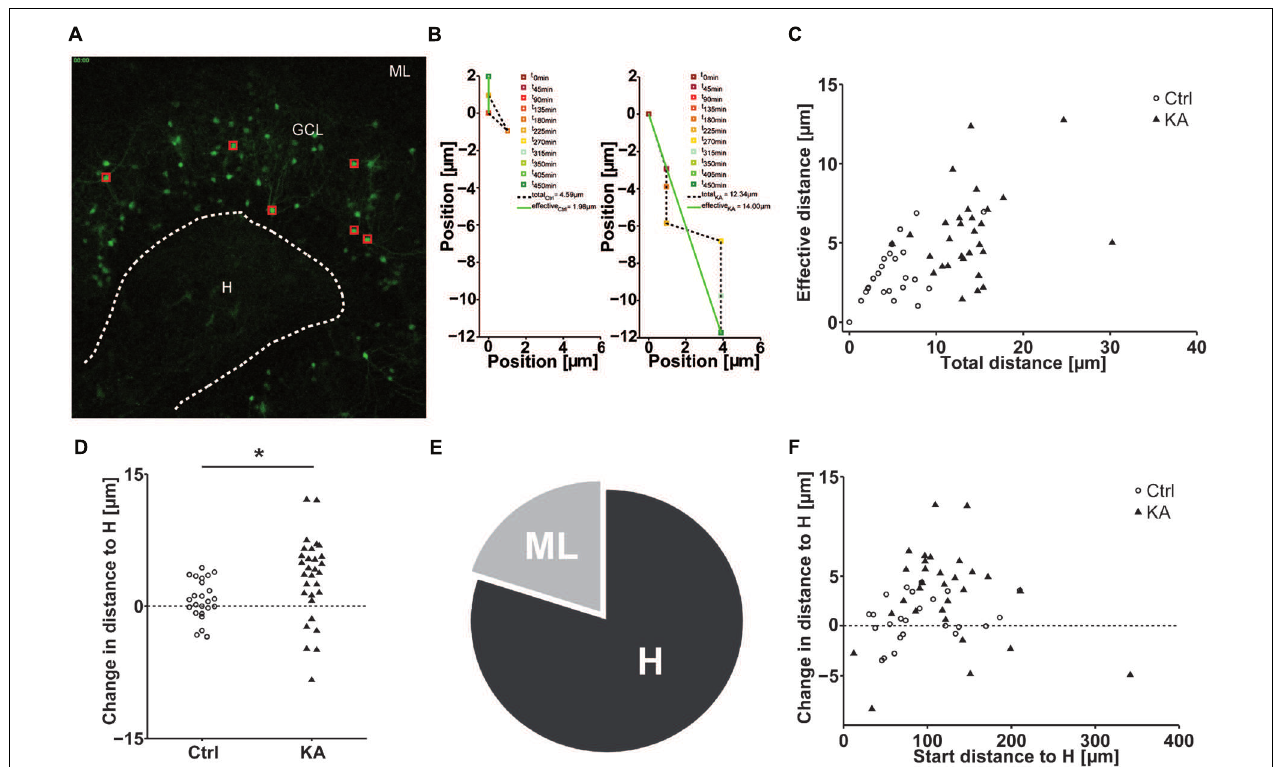
FIGURE 4 | EGFP-positive granule cells migrate preferentially to the hilus. Life cell imaging of individual eGFP-labeled granule cells in the superficial and deep granule cell layer after exposure to KA and in controls over a period of 8 h. (A) Representative photomicrograph of a KA-treated OHSC from a Thy-1 eGFP mouse ( t = 0 min). Red squares indicate the initial position of monitored cells. White dashed line marks the border between the hilus and the GCL, taken as reference to calculate the relative migration distances of individual eGFP-labeled cells. (B) Representative graphs showing the motility of one tracked neuron in a control (left graph) or a KA-treated OHSC (right graph). Cell motility was assessed by calculating both, the total length of the traveled path over 8 h (black dashed line = total distance) and the effective distance of the migration as the length of the resulting vector (green solid line) between start (at x = 0; t = 0 min) and end point ( t = 450 min). (C) Diagram showing the relation between total and effective migration distance of all tracked granule cells. In contrast to controls, all cells change their position after KA treatment. (D) Migration distances of all tracked individual granule cells with respect to the border between hilus and GCL in control ( n = 4, 24 cells) and KA-treated OHSC ( n = 5, 30 cells). To differentiate the migration direction, we marked the border between the hilus and GCL ( A , white dashed line) and calculated the distance of the start and end point of the cells to this border. Cells that reduce their distance to the border over time [H distance ( t = 0 min) – H distance ( t = 450 min), positive values] are considered migrating toward the hilus. Cells showing an increase in distance (negative values) moved toward the ML. Cells in KA-treated OHSC (black triangles) travel longer distances in both directions, toward ML and hilus, than controls (black circles). Two-sample Student’s t -test ( ∗ P < 0.05). Cells which migrate toward the hilus travel longer distances than those heading toward the ML. The majority of cells progresses toward the hilus. (E) Relative distribution of cells traveling toward the hilus (80%) or molecular layer (20%) in KA-treated OHSC. (F) Diagram showing the relation between initial distance to the hilus-GCL border and change in distance to the border of all tracked granule cells. In contrast to controls, all cells change their position after KA treatment and travel longer distances regardless of their position in the deep or superficial granule cell layer. ML, molecular layer; GCL, granule cell layer; H,